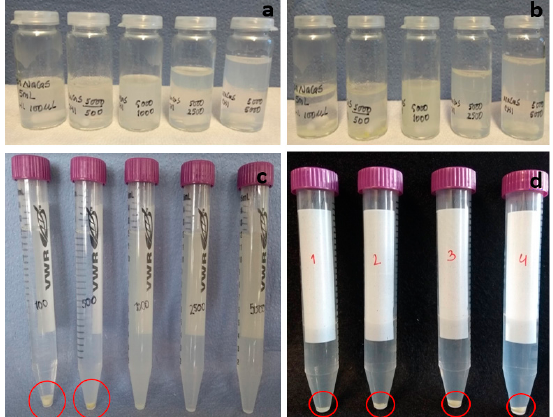
Figure 6. ( a ) Polyelectrolyte complex (PEC) colloidal systems obtained in the experiment (iv) of Case II (caseinate in excess) after adding 0.10, 0.50, 1.00, 2.50, or 5.00 mL of 0.1% (w/w) high molecular weight chitosan HMW CHI solution into 5.00 mL of 0.1% (w/w) of sodium caseinate. ( b ) PEC colloidal systems obtained after furtherly adding 5 µL of the crosslinker glutaraldehyde (GLU). ( c ) Photos showing the sedimented material collected after centrifugation of the PEC colloids shown in ( a ); where sedimented centrifugate (highlighted in red circle) could be collected when lower volumes of 0.10 and 0.50 mL of 0.1% (w/w) chitosan were added. ( d ) Photos showing the sedimented material (highlighted in red circle) collected after centrifugation of the PEC colloids crosslinked with GLU and obtained with intermediate volumes of 0.10, 0.20, 0.50, and 0.75 mL of 0.1% (w/w) HMW CHI added to 0.1% (w/w) NaCas.